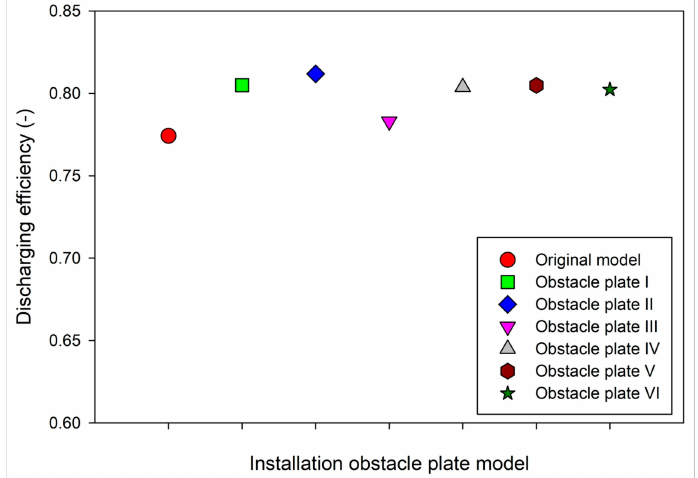
Figure 23. The discharging efficiencies of the obstacle plate models.